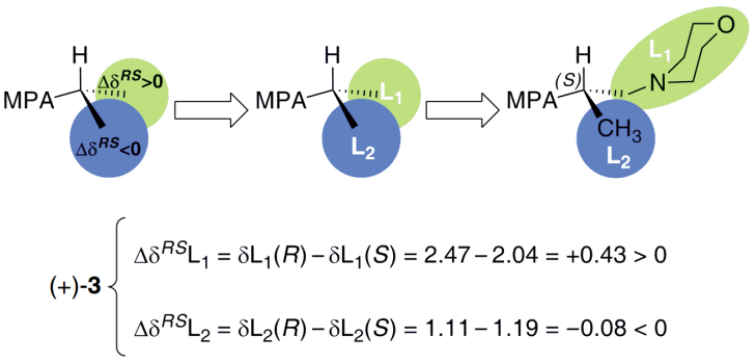
Figure 5. Description of the substituents (L 1 and L 2 ) for determination of the absolute configuration of (+)- 3 and Δδ RS values obtained for the MPA diastereomeric esters ( S )-(+)- 3 -( R )- MPA and ( S )-(+)- 3 -( S )- MPA .